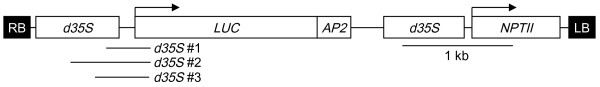
Structure of LUCH and its neighboring transgene. RB and LB, right border and left border of the T-DNA, respectively. The arrows indicate the directions of the coding regions. The d35S fragments (marked #1 to #3) specific for the d35S promoter upstream of LUC are amplified by PCR following digestion with the restriction enzyme McrBC as well as in bisulfite sequencing.